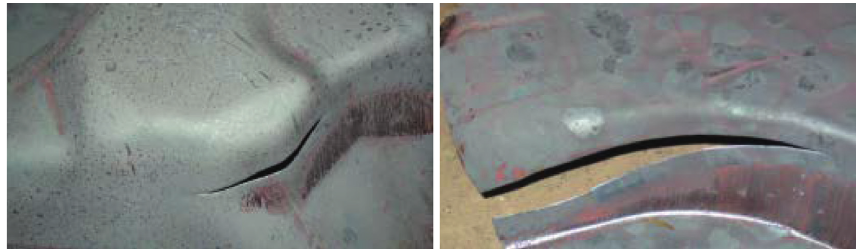
Figure 4: Fractures of the A-pillar during hot